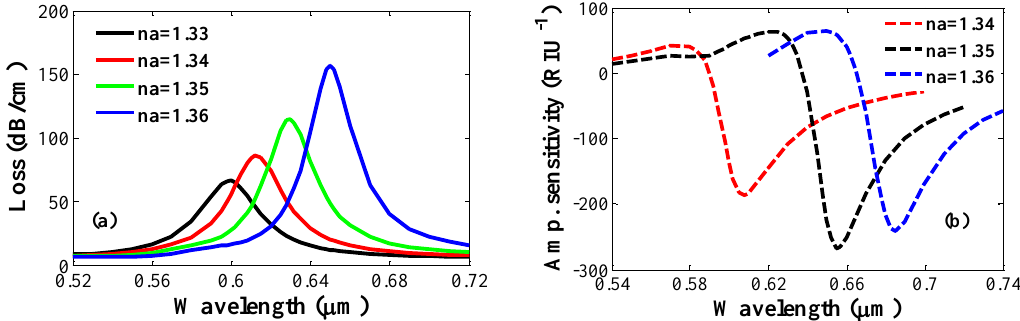
Figure 3. ( a ) Fundamental loss variation for increasing analyte RI from 1.33 to 1.36 and ( b ) amplitude sensitivity for different analyte RI with Λ = 2 μm, d c = d 1 = 0.2Λ, d = 0.4Λ, and t g = 40 nm.